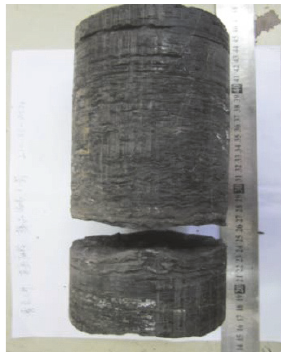
Figure 1: Shale outcrops in Longmaxi formation. Figure 2: Cores from the Longmaxi shale gas